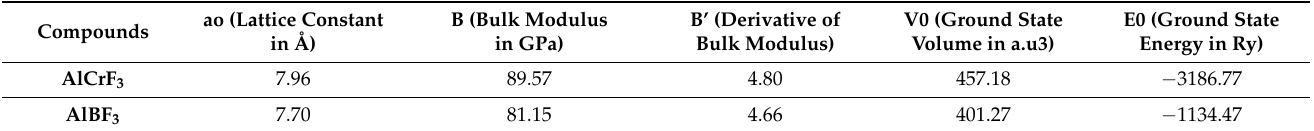
Table 1. Optimized structural characteristics of TlMF 3 (M = Au, Ga) derived using Birch-energy Murnaghan’s vs. volume.